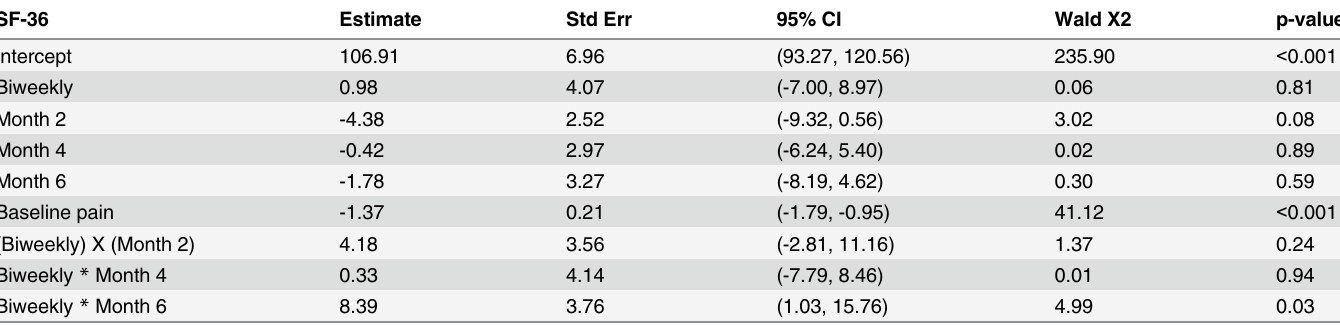
Table 3. Estimates and accompanying statistical values from the GEE modeling of the 6-month outcome